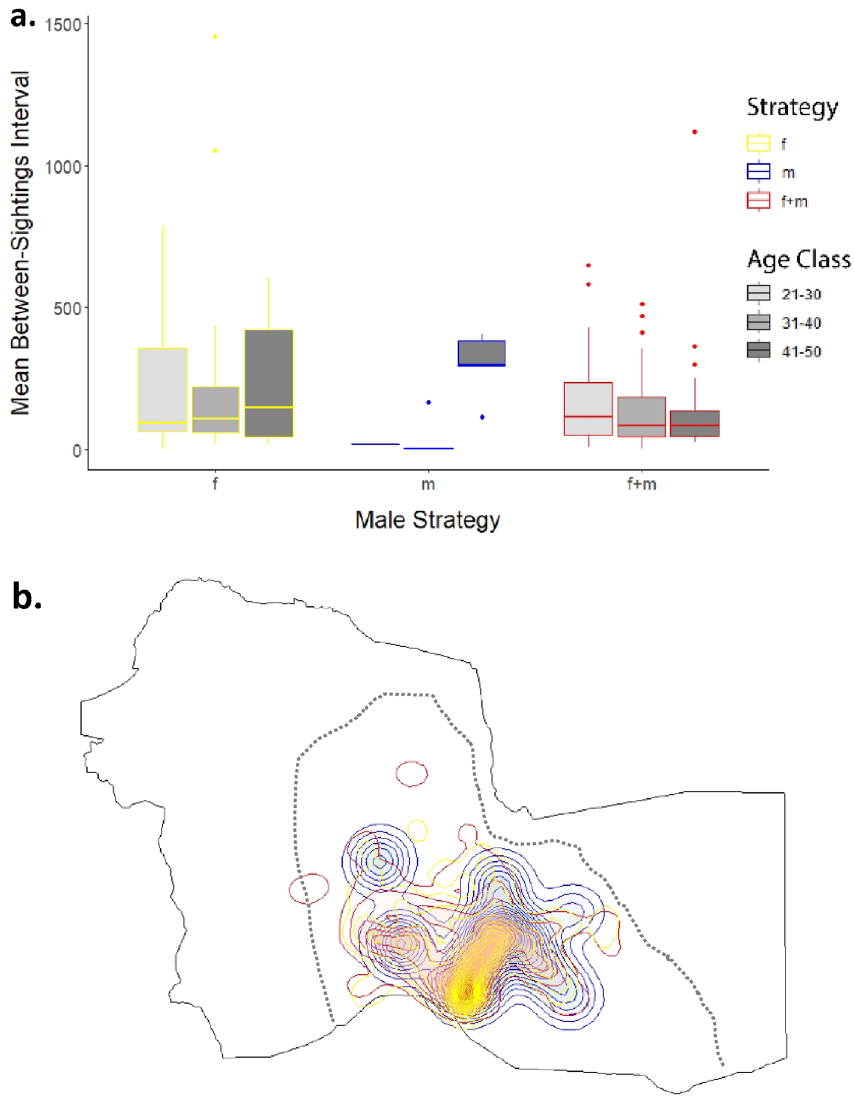
Figure 3. Male PA-use by age and strategy. ( a ) Average length of between-sightings interval (BSI) by male age and strategy. Males employing the foraging-only strategy tend to have longer BSIs on average than those employing other strategies, while age is not overall an important influence. However, there was an interaction of age and strategy, with BSIs of musth-only males being significantly shorter than those with other strategies. This was driven by males aged 21–40, while BSIs of males in the 41–50 age class were significantly longer (see Table 3). ( b ) Space use of males following each of the different strategies, indicated by the same color as ( a ). Males exhibiting different strategies show no visible spatial differentiation within our central observation area. Observation area is defined by the dotted line; lack of data outside this is simply due to sampling, not absence of